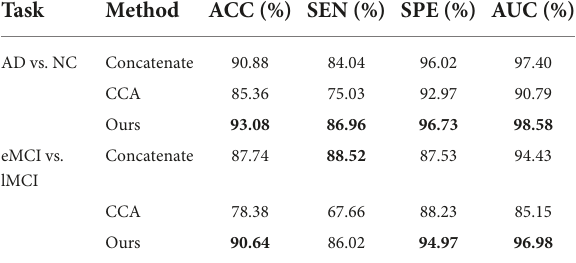
TABLE 5 Classification results of three network fusion methods in two tasks. Task